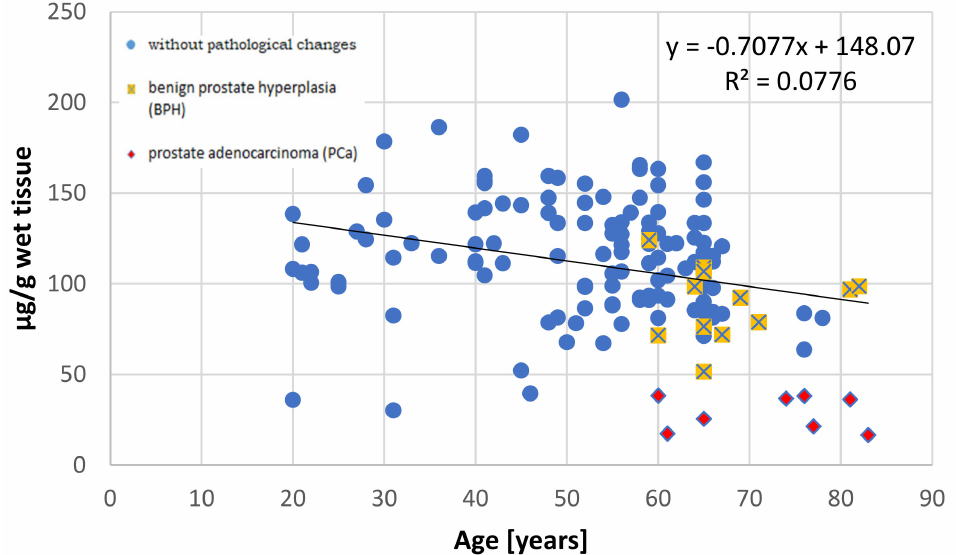
Figure 3. The relationship between zinc concentration ( µ g/g wet tissue) and age (years) in the peripheral part of the human prostate with regard to histopathological